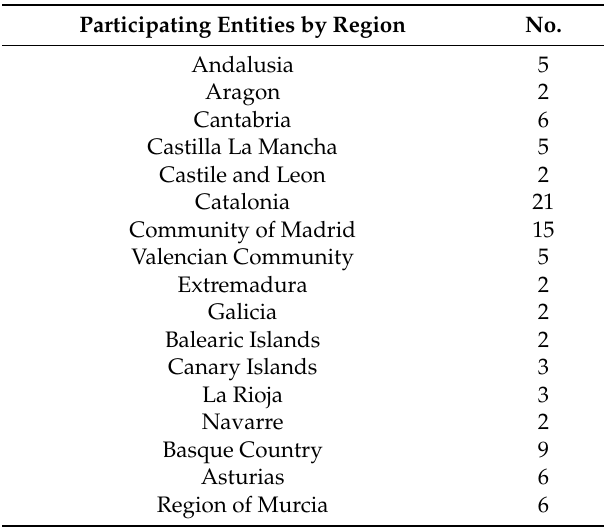
Table 1. Participating entities by